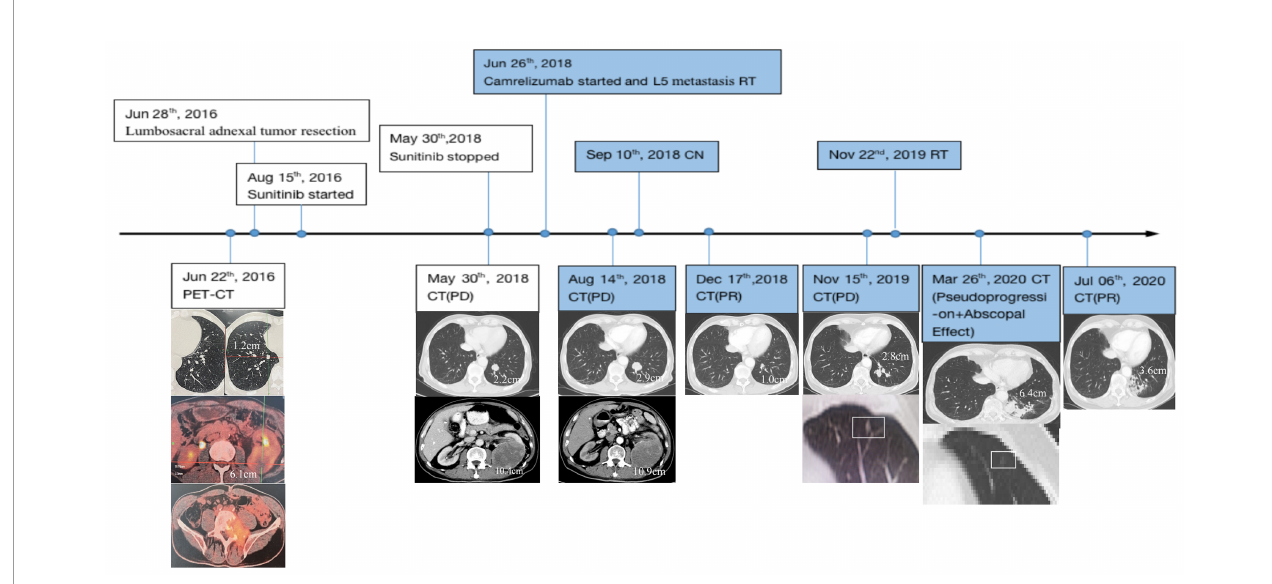
FIGURE 1 | Disease status timeline and PET/CT scan of primary and metastatic lesions accompanied by treatment regimens. CN, cytoreductive nephrectomy; RT, radiotherapy; PET/CT, positron emission tomography-computed tomography/computed tomography; PD, progressive disease; PR, partial response; Point-in-time fi lled with color represents continuous use of